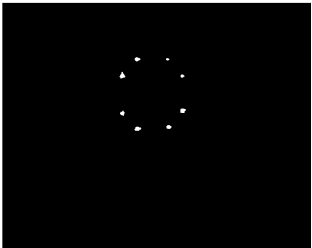
Figure 14. Guidance features extracted from preprocessed image M